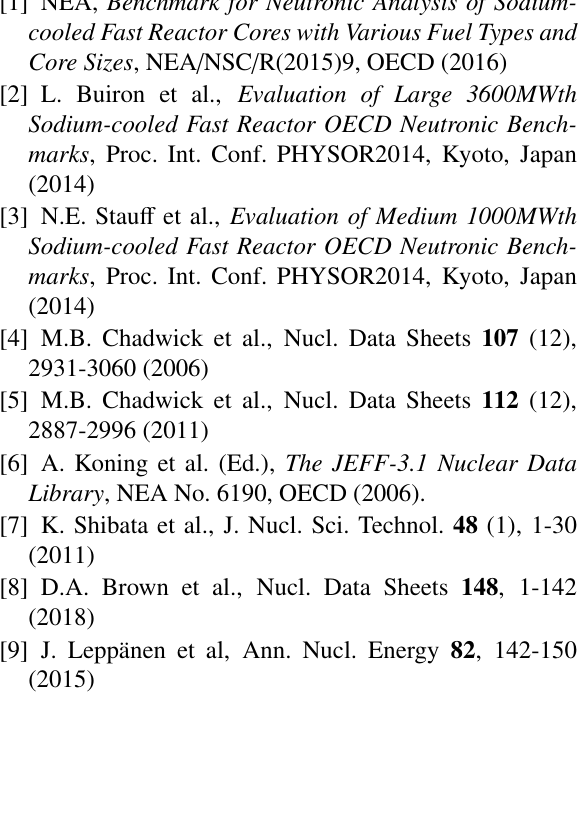
Figure 7. K D of both cores for di ff erent nuclear data libraries